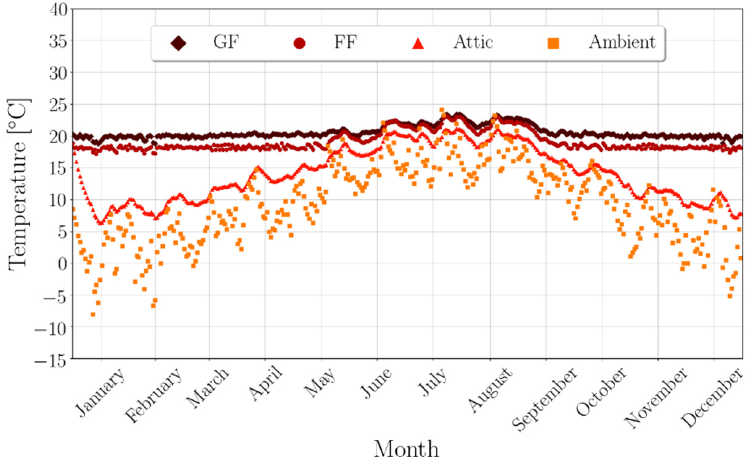
Figure 23. Daily average air temperature in the building together with the environmental air tem- perature and the Running Mean Outdoor Temperature (RMOT).